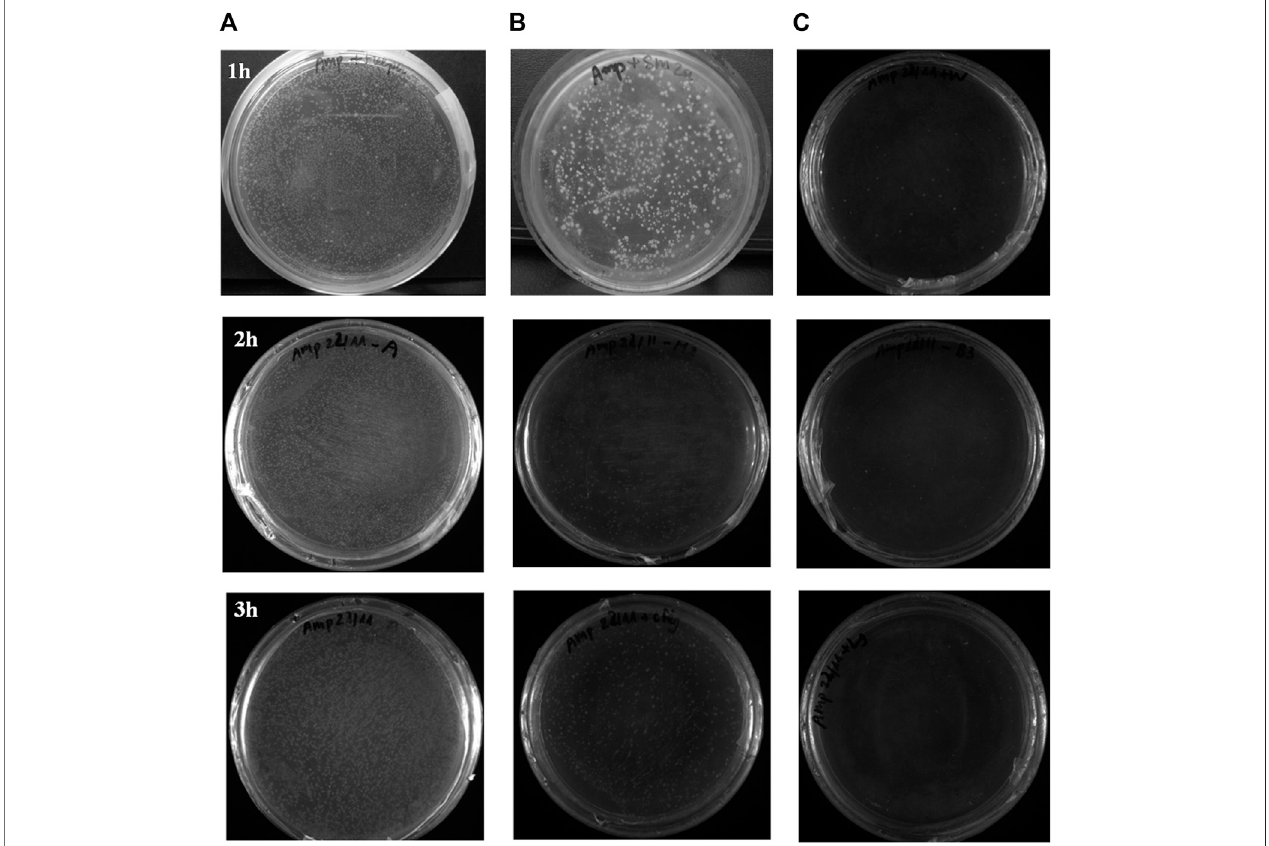
FIGURE9| Theantibacterialevaluationonplatecountagar(PCA)oftheairpassingthroughaquartztubewithoutcoatingmaterial (A) ,WOsilicatecoating (B) ,and W silicate coating (C) from 1 to 3 hours.